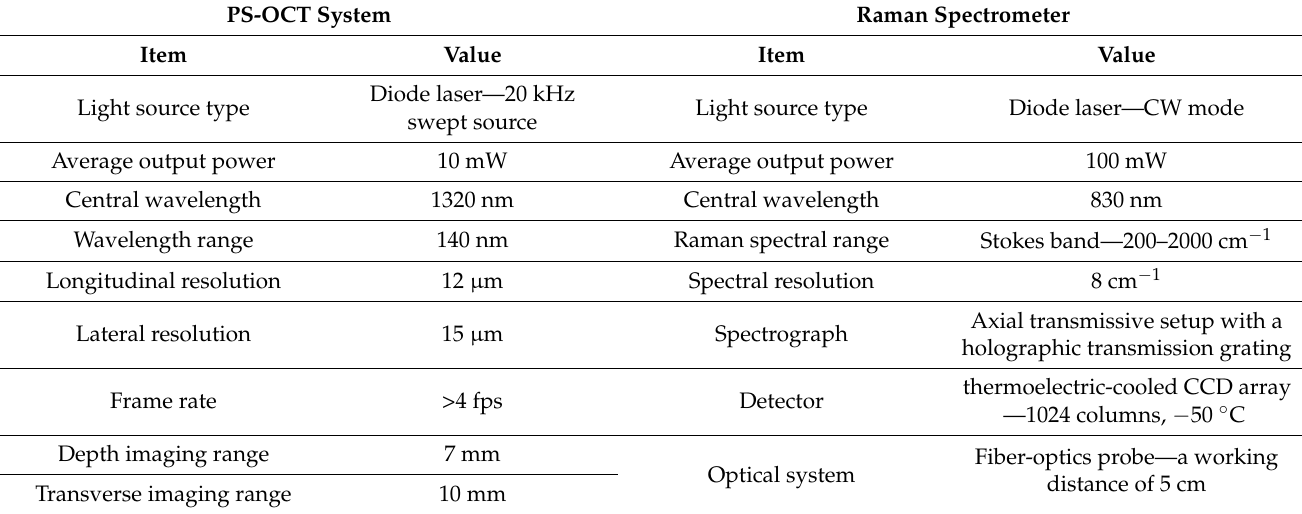
Table 1. Features of the PS-OCT system and the Raman